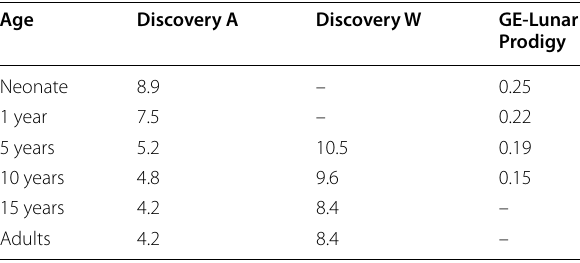
Table 2 Effective radiation dose (µSv) in whole‑body DXA exams in Hologic Discovery W, Discovery A, and GE‑Lunar Prodigy devices [96, 97]